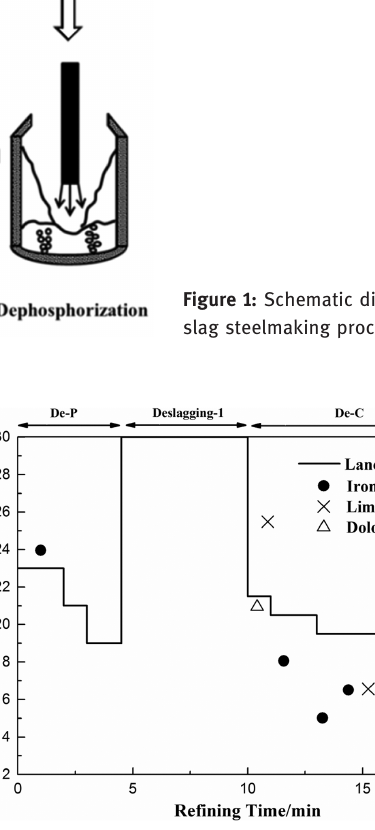
Figure 2: Lance height and feeding condition of double-slag